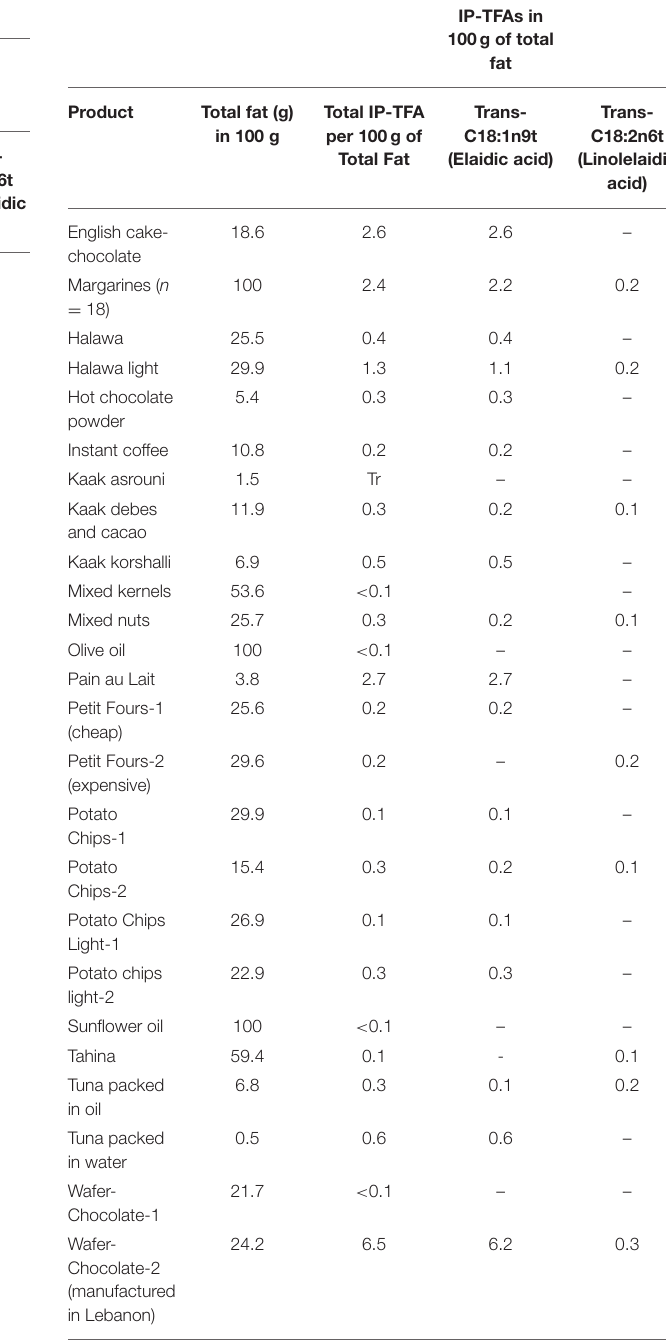
TABLE 3 | Total fat in 100g of edible portions, total IP-TFAs, and IP-TFAS (EA and LEA) in 100g of total fat of market food products collected from Lebanese